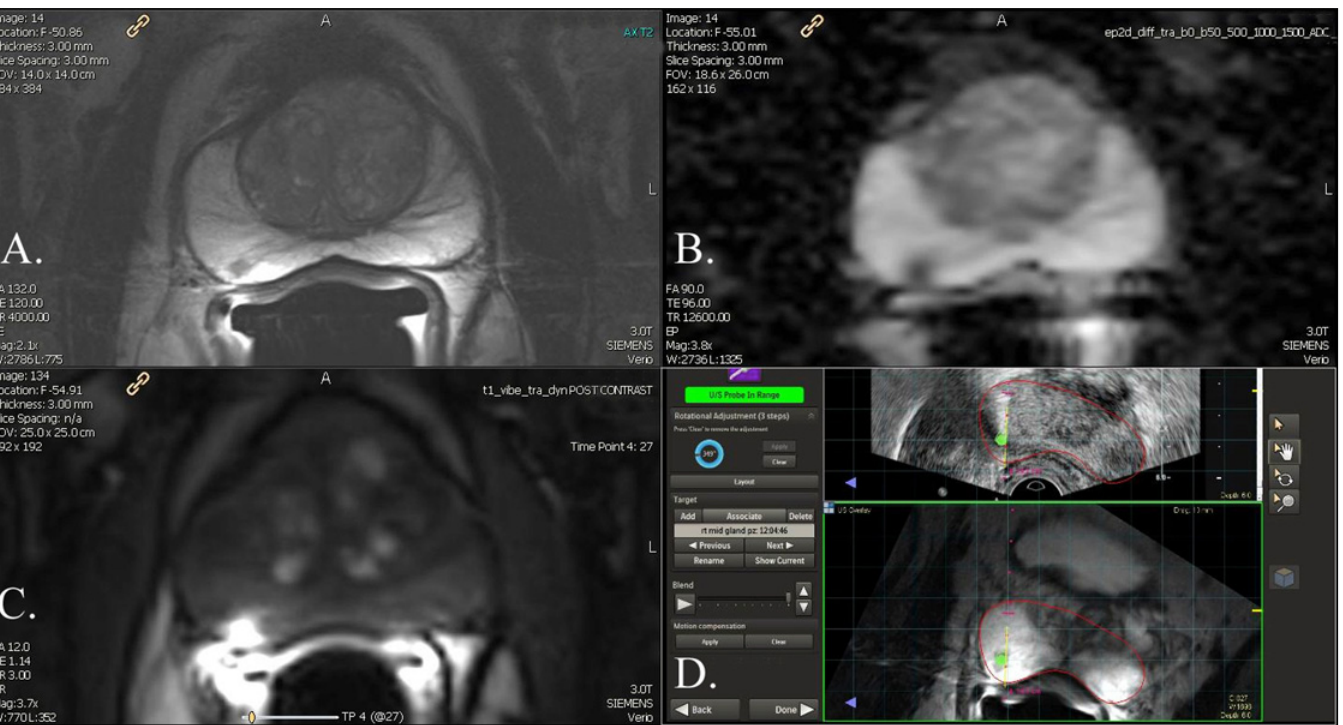
Fig 7. Prostate mpMRI. A. T2 sequence with a low signal intensity in Zone 3L. B. DWI with corresponding ADC restriction C. DCE with early arterial uptake. D. MR US fusion directed biopsy detected Gleason 3+4, 2.5 mm. Please see supplemental report regarding specific lesion based